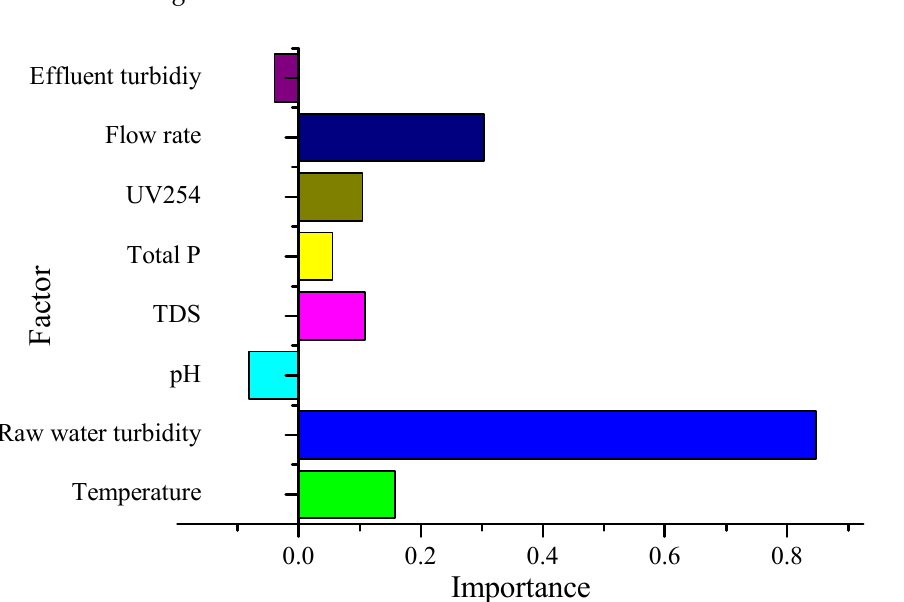
Figure 10. The results of sensitivity analysis of the model to input variables.